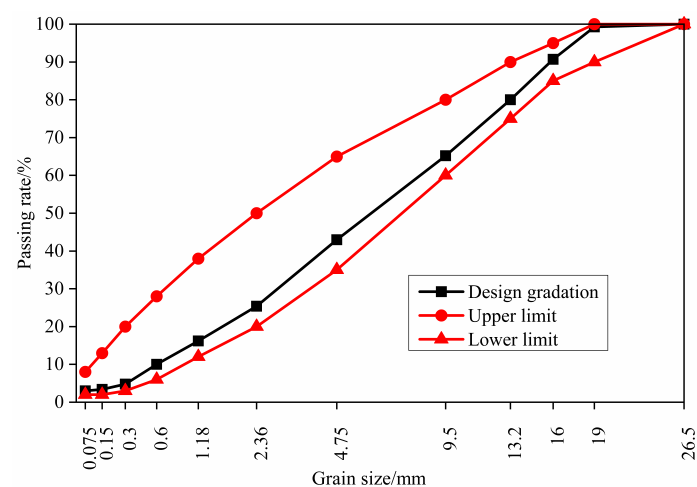
Figure 1. Grading curve of